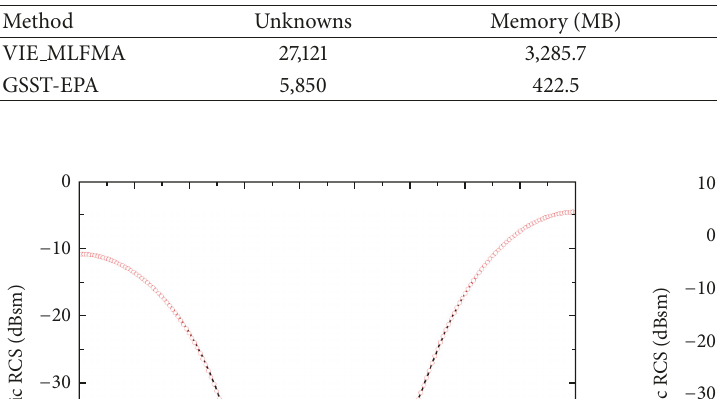
Table 2: The comparison of computational results.